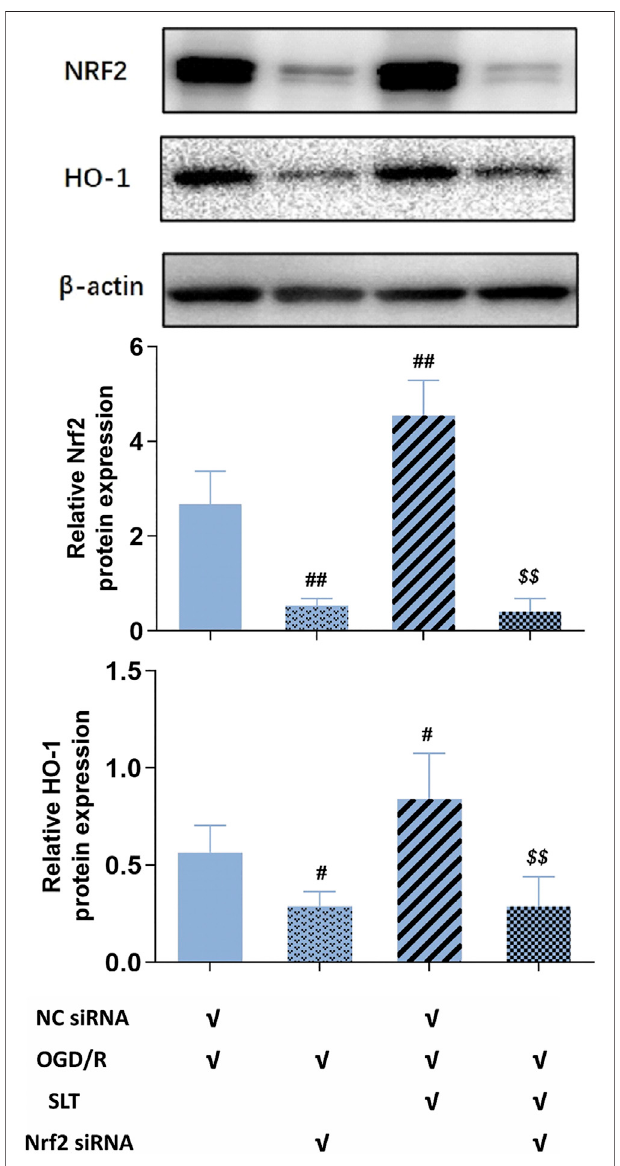
FIGURE7| Nrf2siRNAabrogatedactivationofSLTontheNrf2pathway incerebralmicrovascularendothelialcellsinOGD/Rinjury.Dataareexpressed as mean ± SD ( n (cid:1) 3). # p < 0.05, ## p < 0.01 vs. NC siRNA + OGD/R group; $ p < 0.05, $$ p < 0.01, vs. NC siRNA + OGD/R + SLT group.